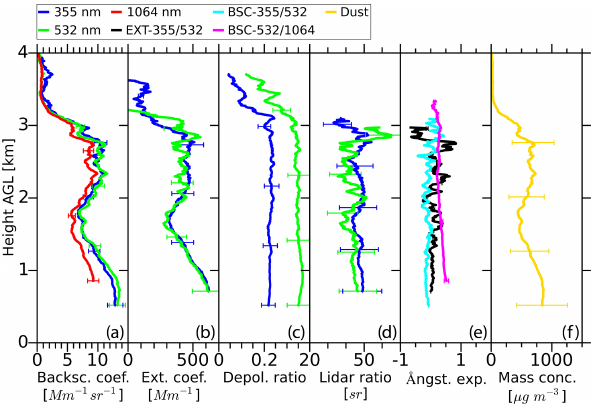
Figure 6. Case 2: an extreme dust layer with an AOT of 1.5 (at 532nm wavelength) and a calculated dust mass concentration of 845µgm − 3 is shown. The source regions of this dust are in Central Asia (Fig. 4f). (a–f) Same as Fig. 5b. The averaged lidar profiles were measured on 8 August 2015, 22:20–23:57UTC. Lidar signals are smoothed before calculation of the extinction-related (458m) and backscatter-related (68m) optical properties.